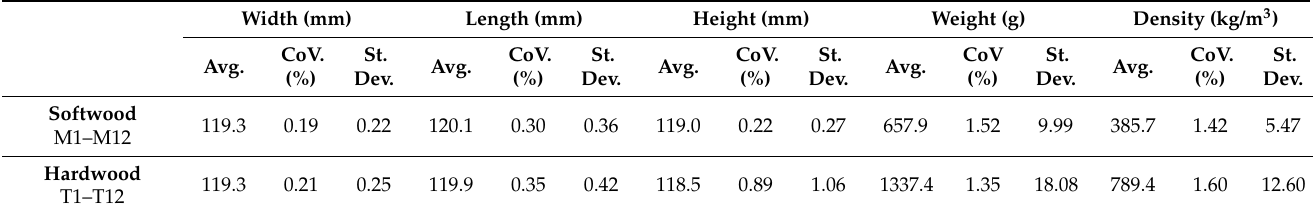
Table 1. Density of cube